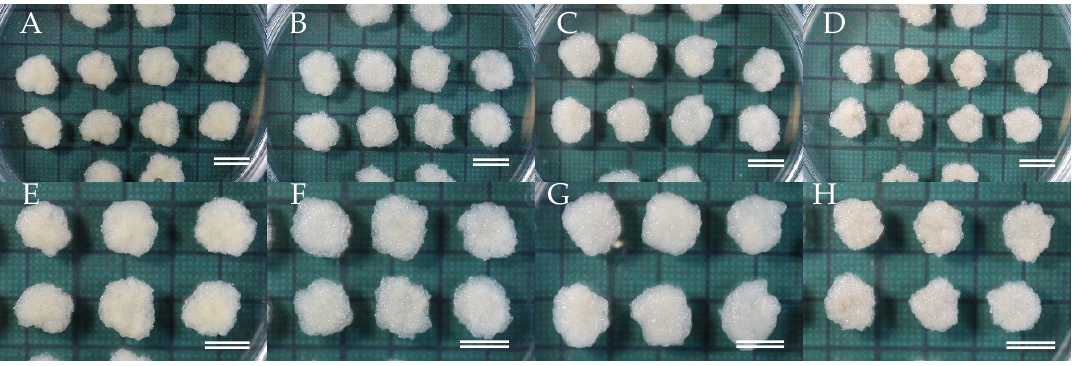
Figure 2. Embryogenic cell proliferation from different seed families: ( A , E ) line from ‘Shindai 3’×’Suzu 2’ family, ( B , F ) line from ‘Fukushima-funen 1’×’S3-37(1)’ family, ( C , G ) line from ‘Fukushima-funen 1’×’Oi 7’ family, ( D , H ) line from ‘Fukushima-funen 1’×’S3-118(2)’ family. Bars 1 cm.